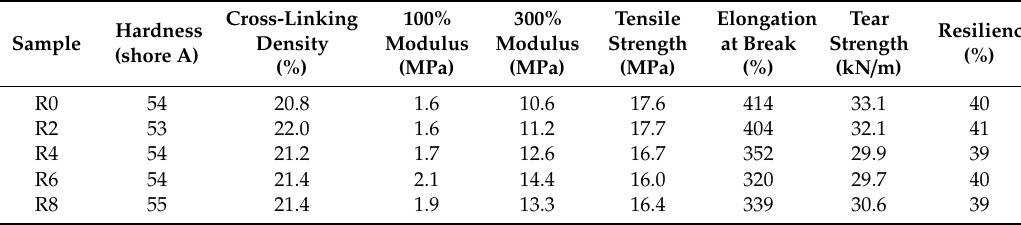
Table 3. Physical-mechanical properties of silica-filled solution-polymerized styrene-butadiene rubber /butadiene rubber (SSBR/BR) vulcanizates.